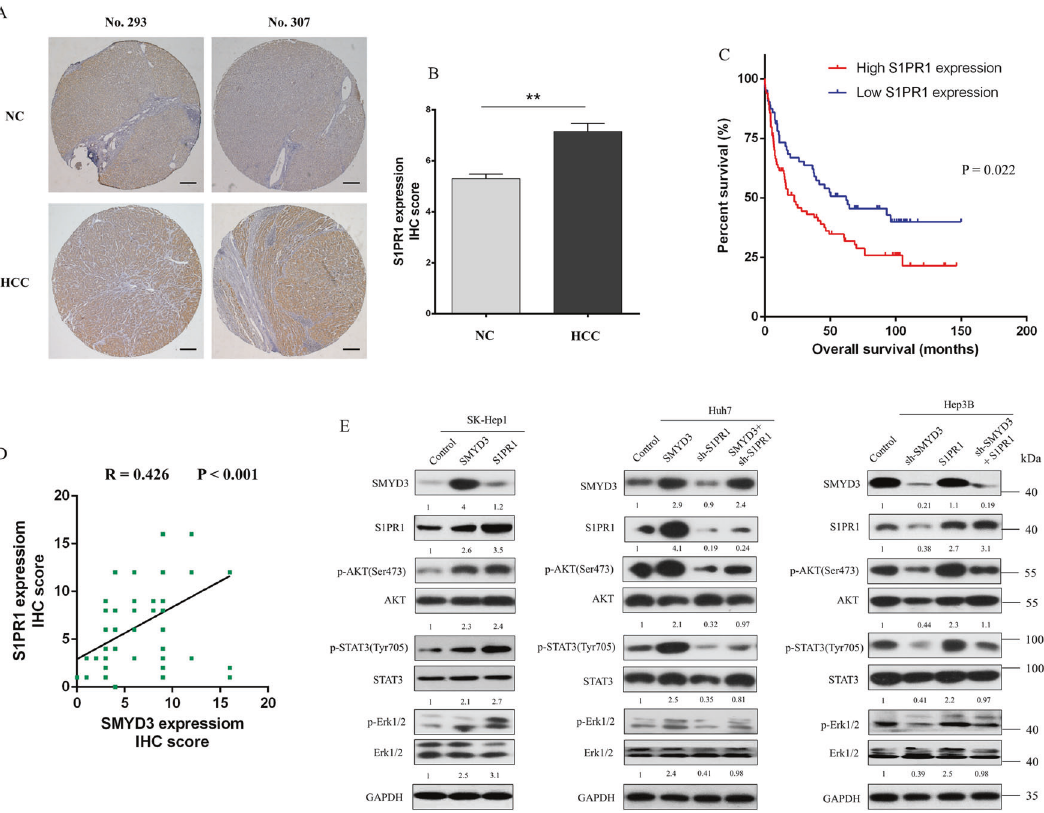
Fig. 5 SMYD3 regulated its downstream signaling pathways via S1PR1. A IHC staining was performed on paired tumor and adjacent noncancerous tissues from 148 patients with HCC. B Statistical analysis of the IHC scores between HCC and adjacent normal tissues. C Kaplan- Meier analysis of overall survival in patients with HCC strati fi ed according to the S1PR1 expression status. The median expression level of S1PR1 was used as the cut-off. D Clinical samples from the same set of tissues were analyzed in the two groups as indicated. The correlation between SMYD3 and S1PR1 expression was assessed by performing a linear regression analysis. E Western blot analysis of SMYD3, S1PR1, p-AKT, AKT, p-STAT3, STAT3, p-Erk1/2, and Erk1/2 expression levels in control cells and cells overexpressing S1PR1 and cells overexpressing SMYD3 combined with knockdown of SMYD3 or S1PR1. Images are representative of two experiments. Bar = 200 μ m. * P < 0.05; ** P <